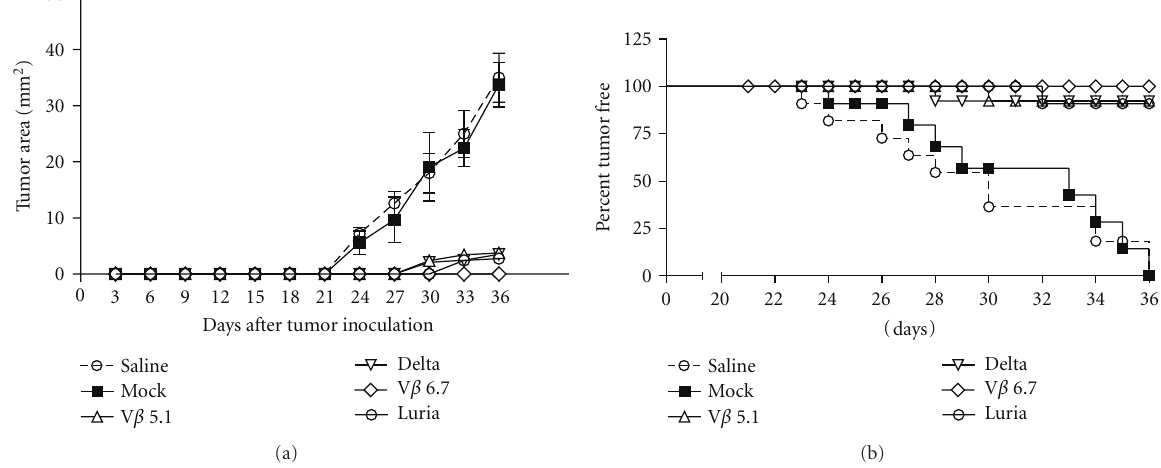
Figure 5: Significantly reduced tumor burden and enhanced tumor-free survival in nude mice implanted with LMP2-expressing tumors after infused with transduced T cells. (a) Tumor mouse model was established as described. After 7 days, mice were infused with di ff erent lentiviral transduced T cells twice at a 1-week interval. PBS-immunized mice were used as control. Tumor growth was recorded twice a week. Tumor sizes are expressed as the average of two perpendicular diameters of the tumor. Graphs show mean ± SE; ∗ P < 0 . 05; n = 8/group. (b) Comparison of survival times of tumor-bearing mice infused with T cells ex vivo transduced by lentivirus containing LMP2-TCR α and β chains driven by various T-cell promoters. Tumor burden was monitored on a weekly basis. Significant di ff erences were observed for all transduced T-cell vaccination group. ∗ P < 0 . 01; n = 14/group. Note: tumor growth rates and survival times were discontinued when the tumor reached 1cm 2 and the mouse was